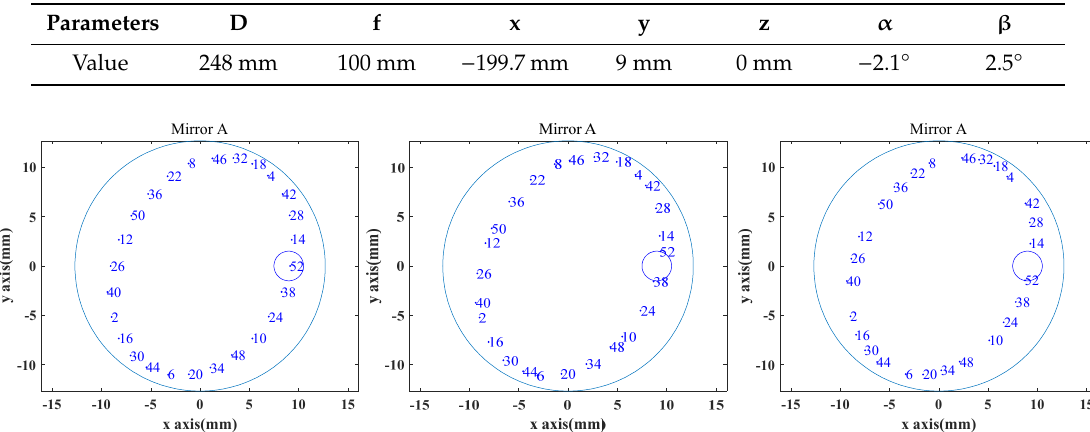
Table 2. The parameters used in the simulation of Herriott.